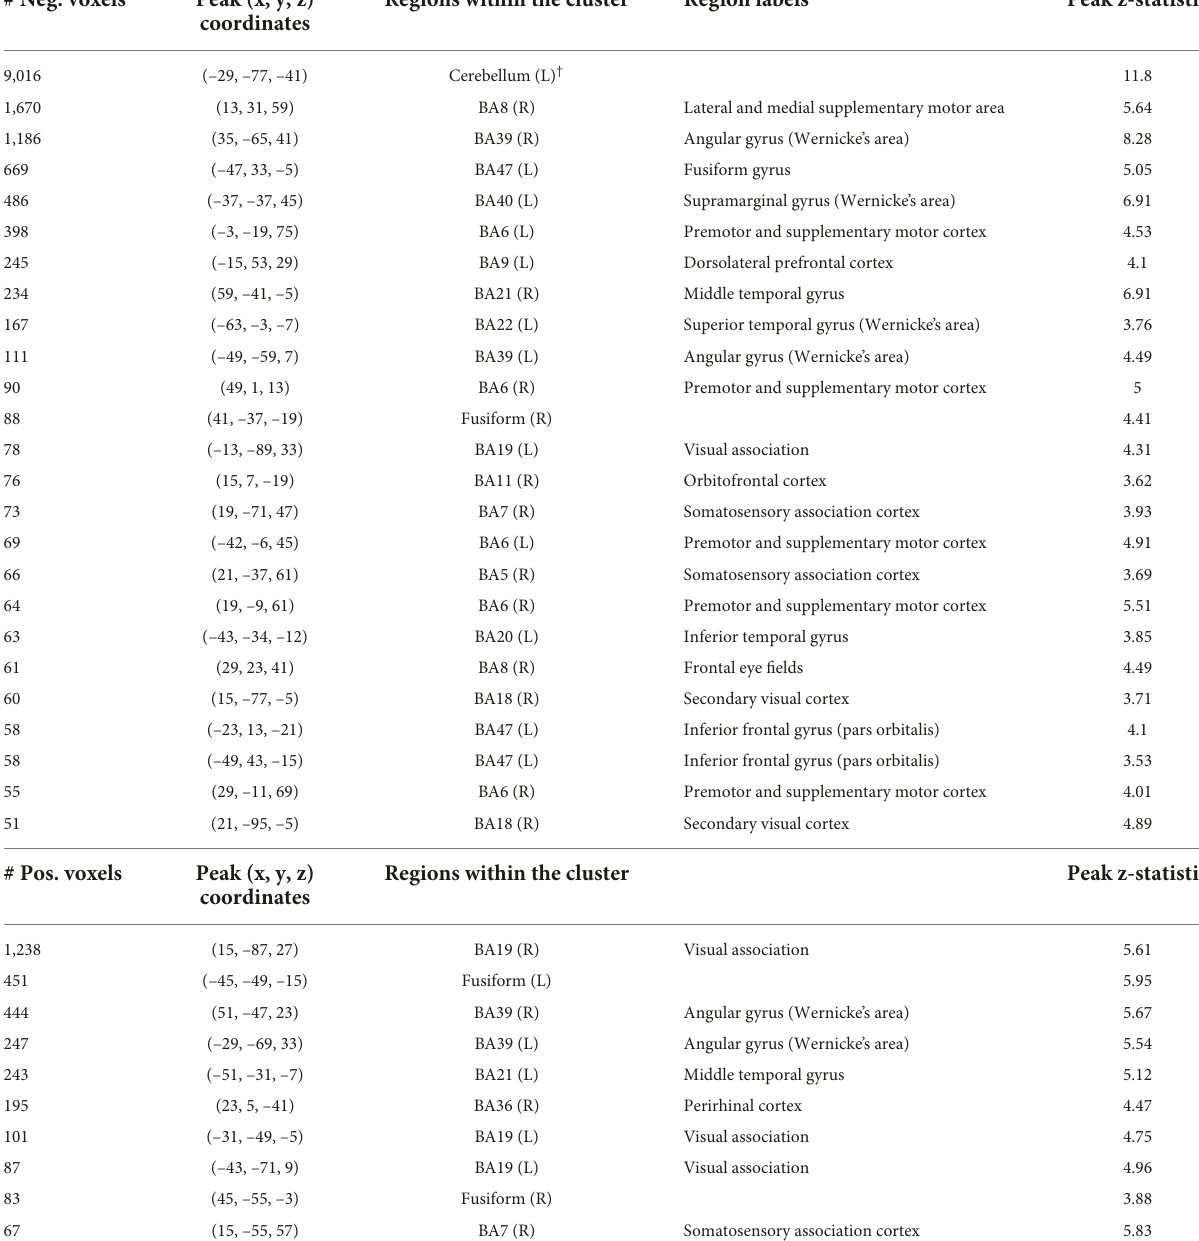
TABLE 2 Characterization of component 10 voxel-based morphometry gray matter